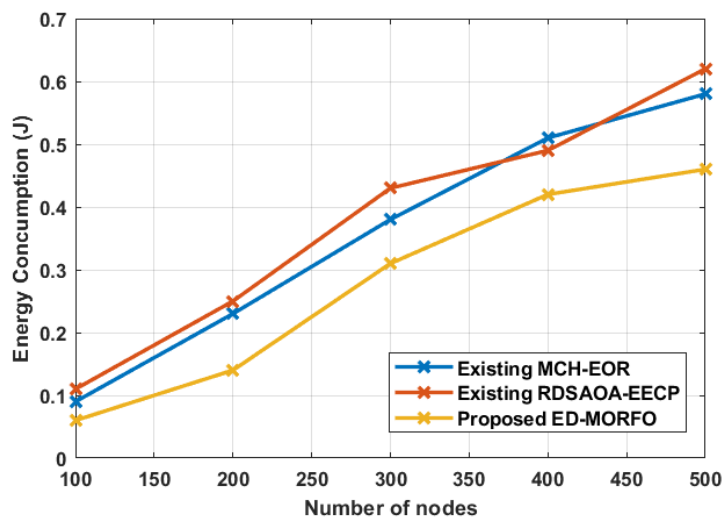
Figure 3. Performance of energy consumption for proposed EDMORFO and Existing MCH-EOR [24], RDSAOA-EECP [25].